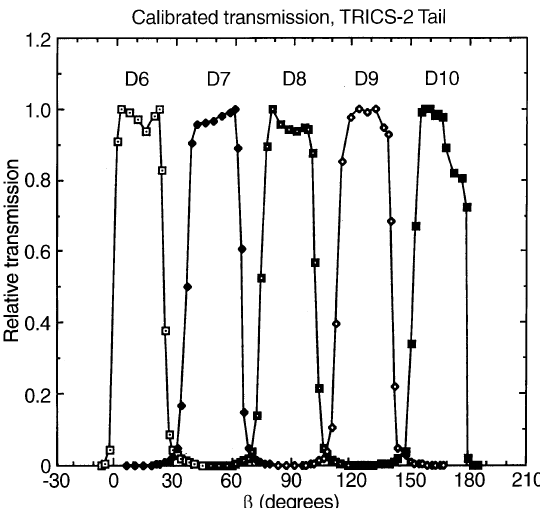
Fig. 5. Calibrated field of view of TRICS-2-Tail